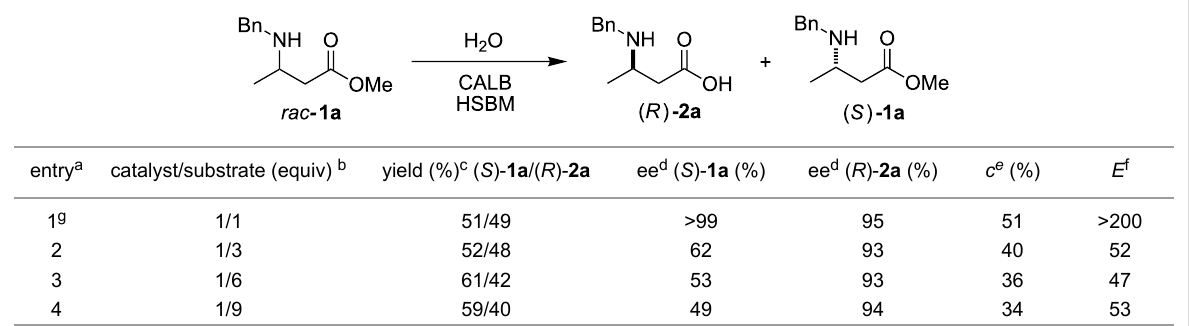
entry a catalyst/substrate (equiv) b yield (%) c ( S )- 1a /( R )- 2a ee d ( S )- 1a (%) ee d ( R )- 2a (%) 1 g 1/1 2 1/3 52/48 3 1/6 1/9 59/40 a Reactions were carried out with 0.5 equivalents of water at 15 Hz during 1 h. b 1 equivalent of enzyme = 40 mg; 1 equivalent of susbtrate = 82 mg. c Determined after purification by flash chromatography. d Determined by HPLC with chiral stationary phase. e Calculated from c = ee s /(ee s + ee p